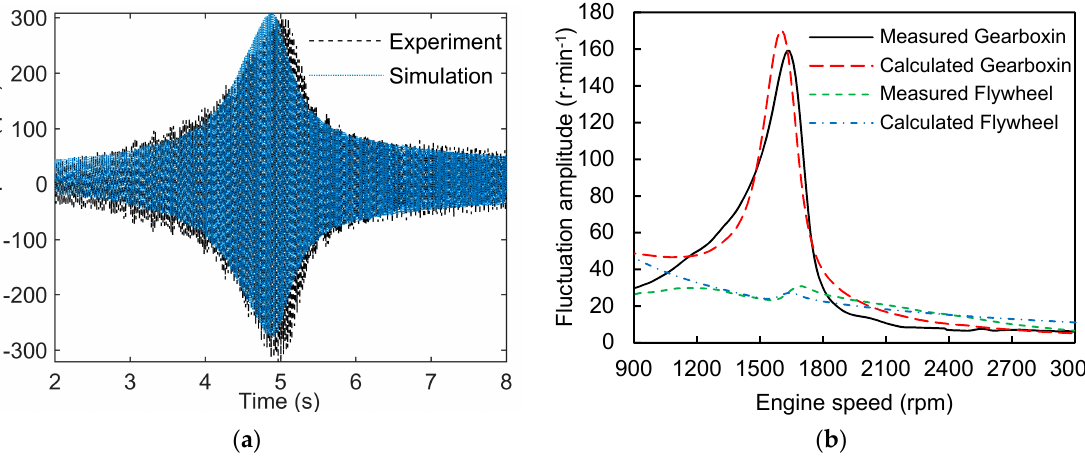
Figure 7. Comparisons of the measured and calculated results. ( a ) The relative velocity through the clutch damper; ( b ) the second − order speed fluctuation.